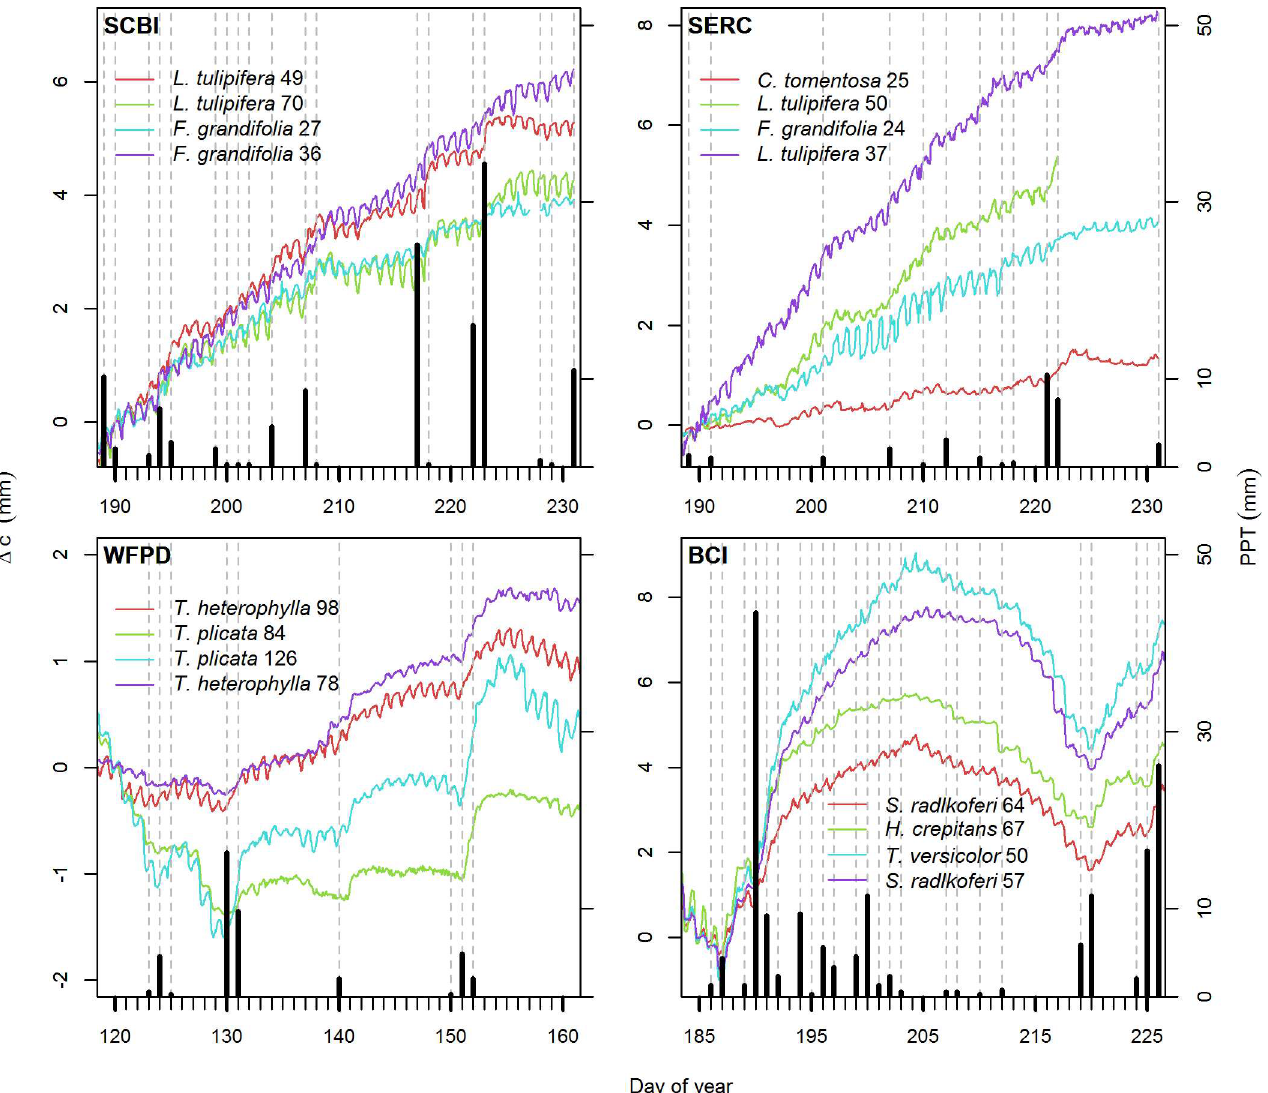
Fig 6. Example responses of trees at each of the four study sites to rain events. Vertical dashedgrey lines are rainy days and vertical solid black lines are precipitationamounts. Each colored line represent one tree, with speciesand DBH (cm) indicatedin legends. Trees were selectedfor relativelystrong rain responses and good data records over a 40-day time periodselectedto focus on rain events.